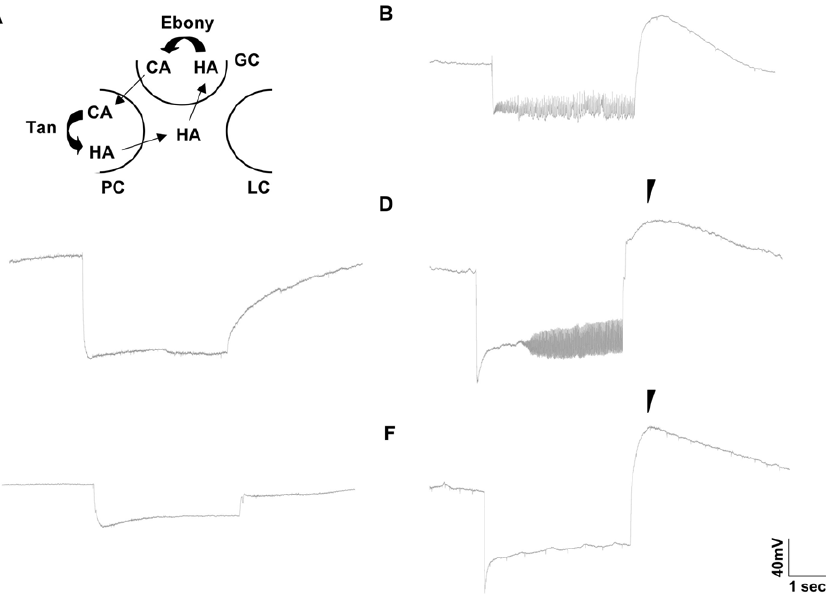
Figure 3. Ebony, But Not Tan, Activity Is Required for the ine Mutant ERG Phenotype (A) Simplistic diagram showing the recycling of histamine in the Drosophila eye. HA, histamine; CA, carcinine; PC, photoreceptor cell; LC, postsynaptic laminar cell, and GC, glial cell. Histamine is taken up from the synaptic cleft by glial cells where it is converted by ebony into carcinine. Carcinine is then shipped to photoreceptor cells where it is converted back to histamine by the enzyme tan. ERG recordings from (B) ine 2 , (C) tan, (D) tan 1 ;ine 2 , (E) ebony 11 , and (F) ine 2 ;ebony 11 flies. Note that ine 2 oscillations are rescued by mutations in ebony but not in tan.